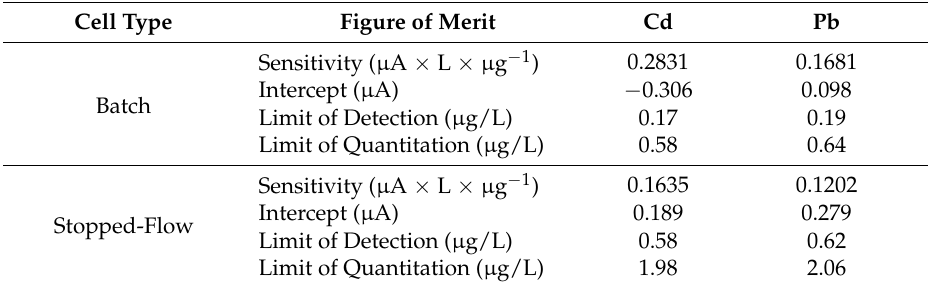
Table 1. Figures of merit of Cd and Pb analysis under differential pulse stripping voltammetry. Comparison between batch and stopped ‐ flow conditions.